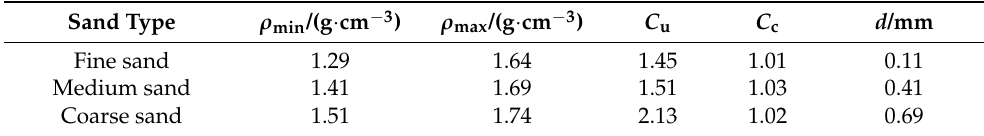
Figure 1. Sandy soil particle size distribution curve. Table 1. The basic physical parameters of the sand.